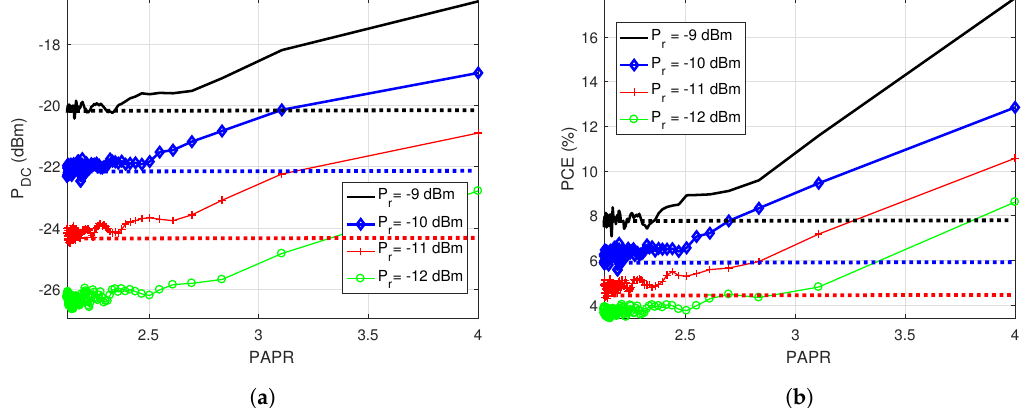
Figure 4. Simulated ( a ) direct current (DC) output power ( P DC ) and ( b ) power conversion efficiency (PCE) as a function of signal’s PAPR at different received power levels at the receiver; the dotted lines of the same color plot the corresponding P DC and PCE using CW (continuous-wave)